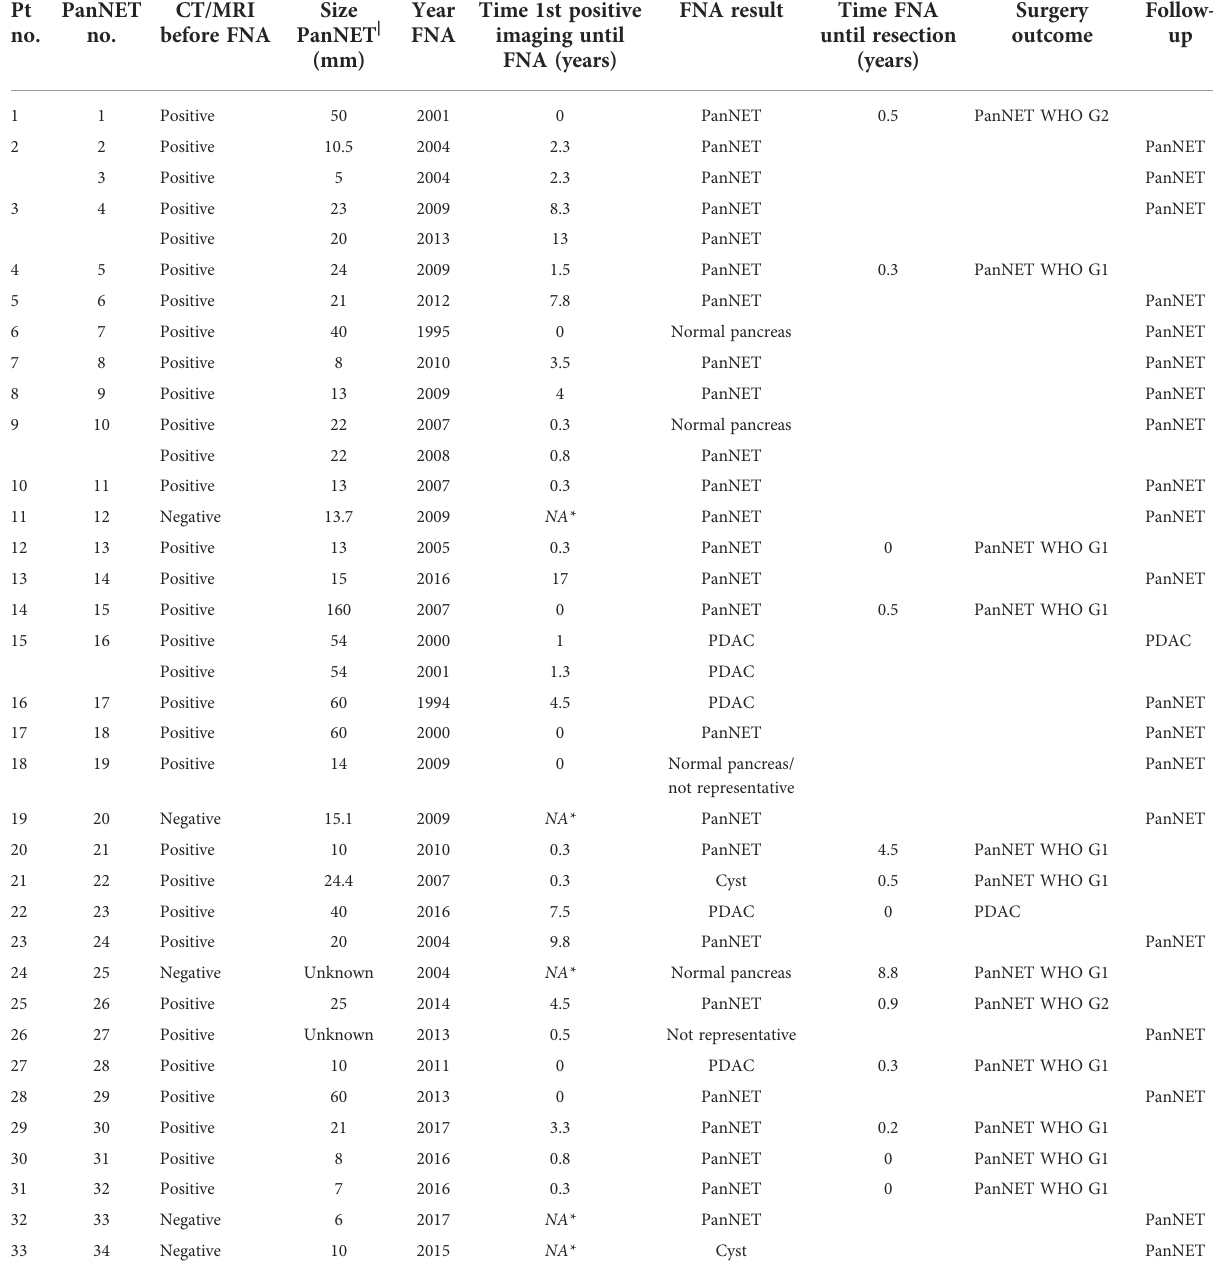
TABLE 6 FNA results in individual patients. Pt PanNET no.